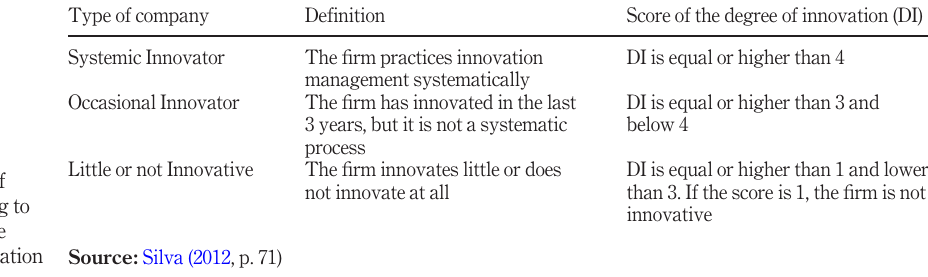
Table IV. Classi fi cation of MSEs according to the scores of the degree of